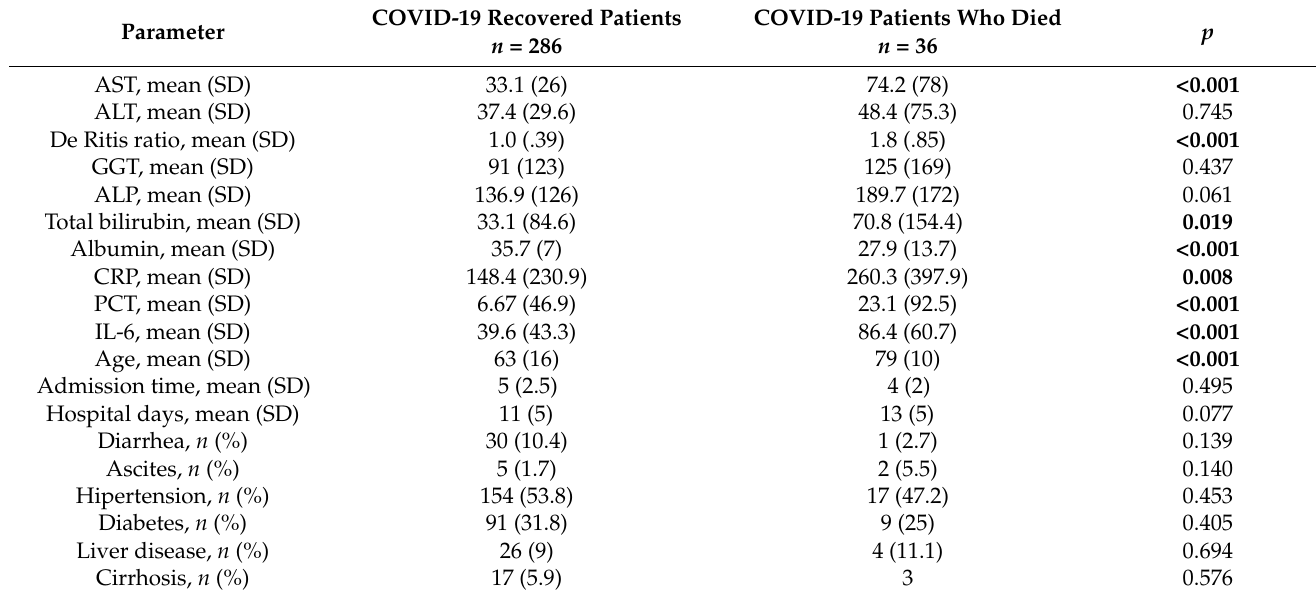
Table 2. Comparison of clinical conditions and laboratory results on admission between COVID-19 recovered patients and COVID-19 patients who died.